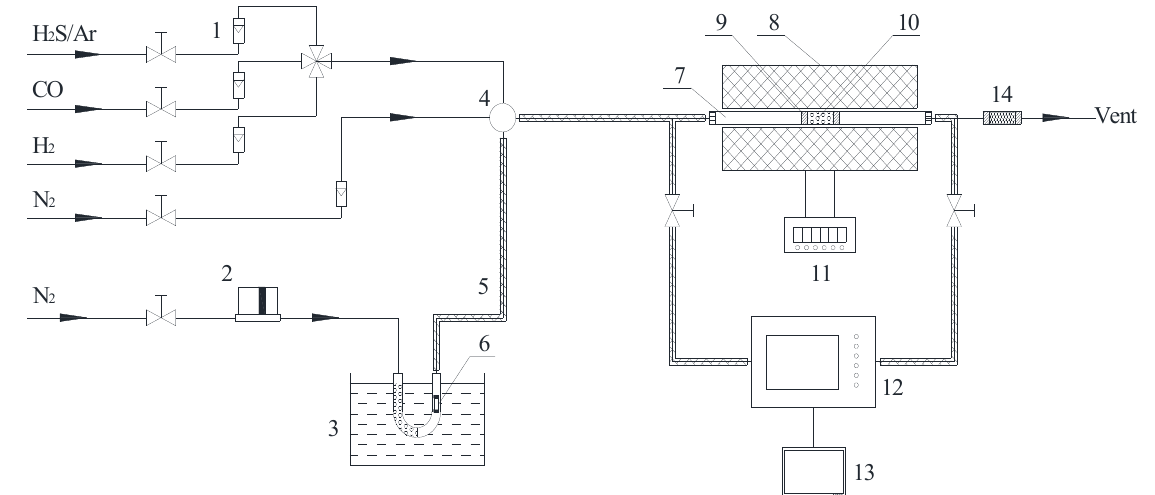
Figure 1. Schematic diagram of Hg 0 and H 2 S removal experiment: (1) rotameter; (2) mass flow controller; (3) water bath; (4) gas mixing chamber; (5) heating tape; (6) Hg 0 permeation tube; (7) quartz reactor; (8) furnace; (9) quartz wool; (10) catalyst; (11) temperature controller; (12) mercury/H 2 S analyzer; (13) computer; (14) tail gas cleaner.